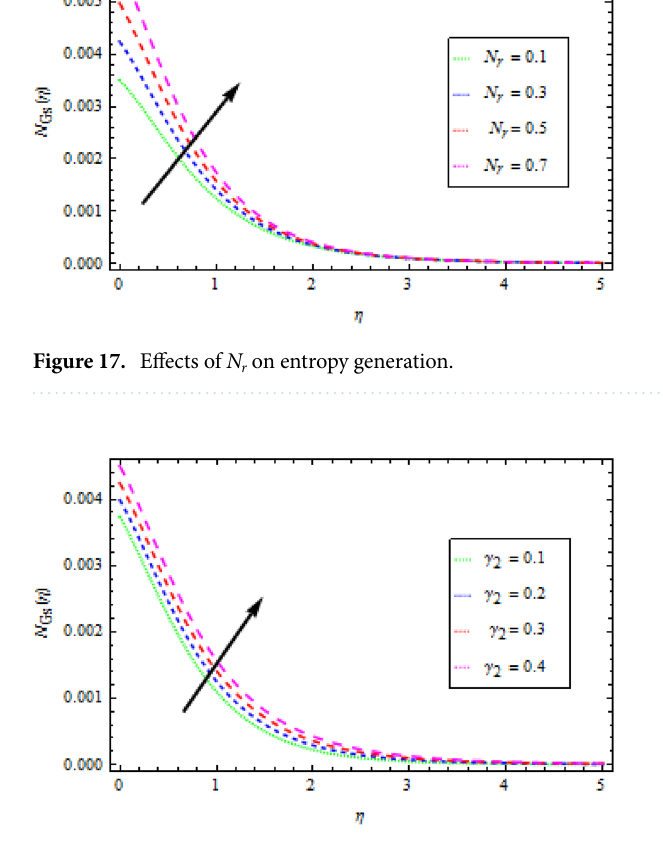
Figure 18. Effects of γ 2 on entropy